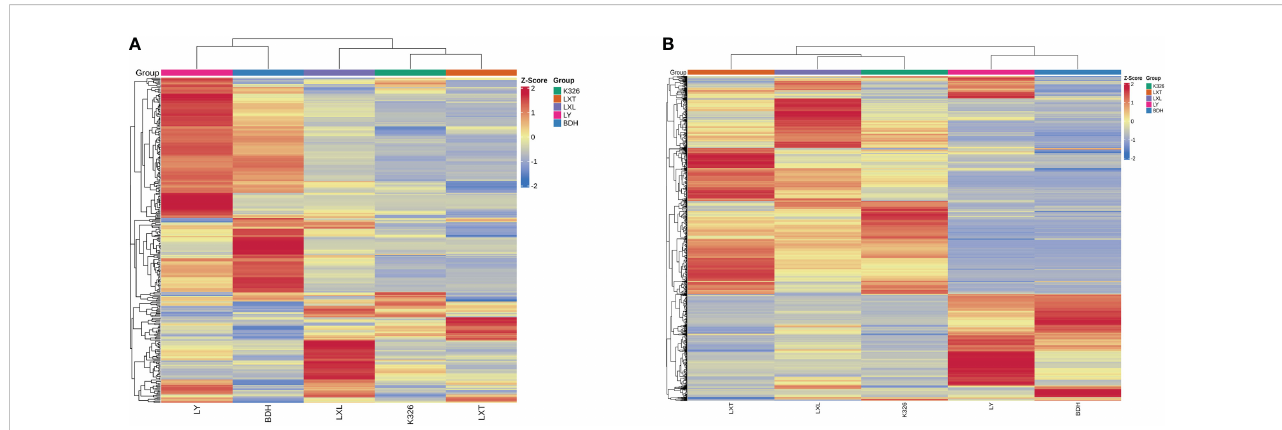
FIGURE 2 Hierarchical clustering of volatile (A) and non-volatile (B) pro fi les of tobacco leaf by variety. Volatile and non-volatile metabolite data were normalized within each variety via z-transformation. The resulting z-scores were converted into colors and grouped using hierarchical clustering. The color in each cell represents the z-transformed abundances of the averaged replicates (n = 3) per tobacco variety (red: high, blue: